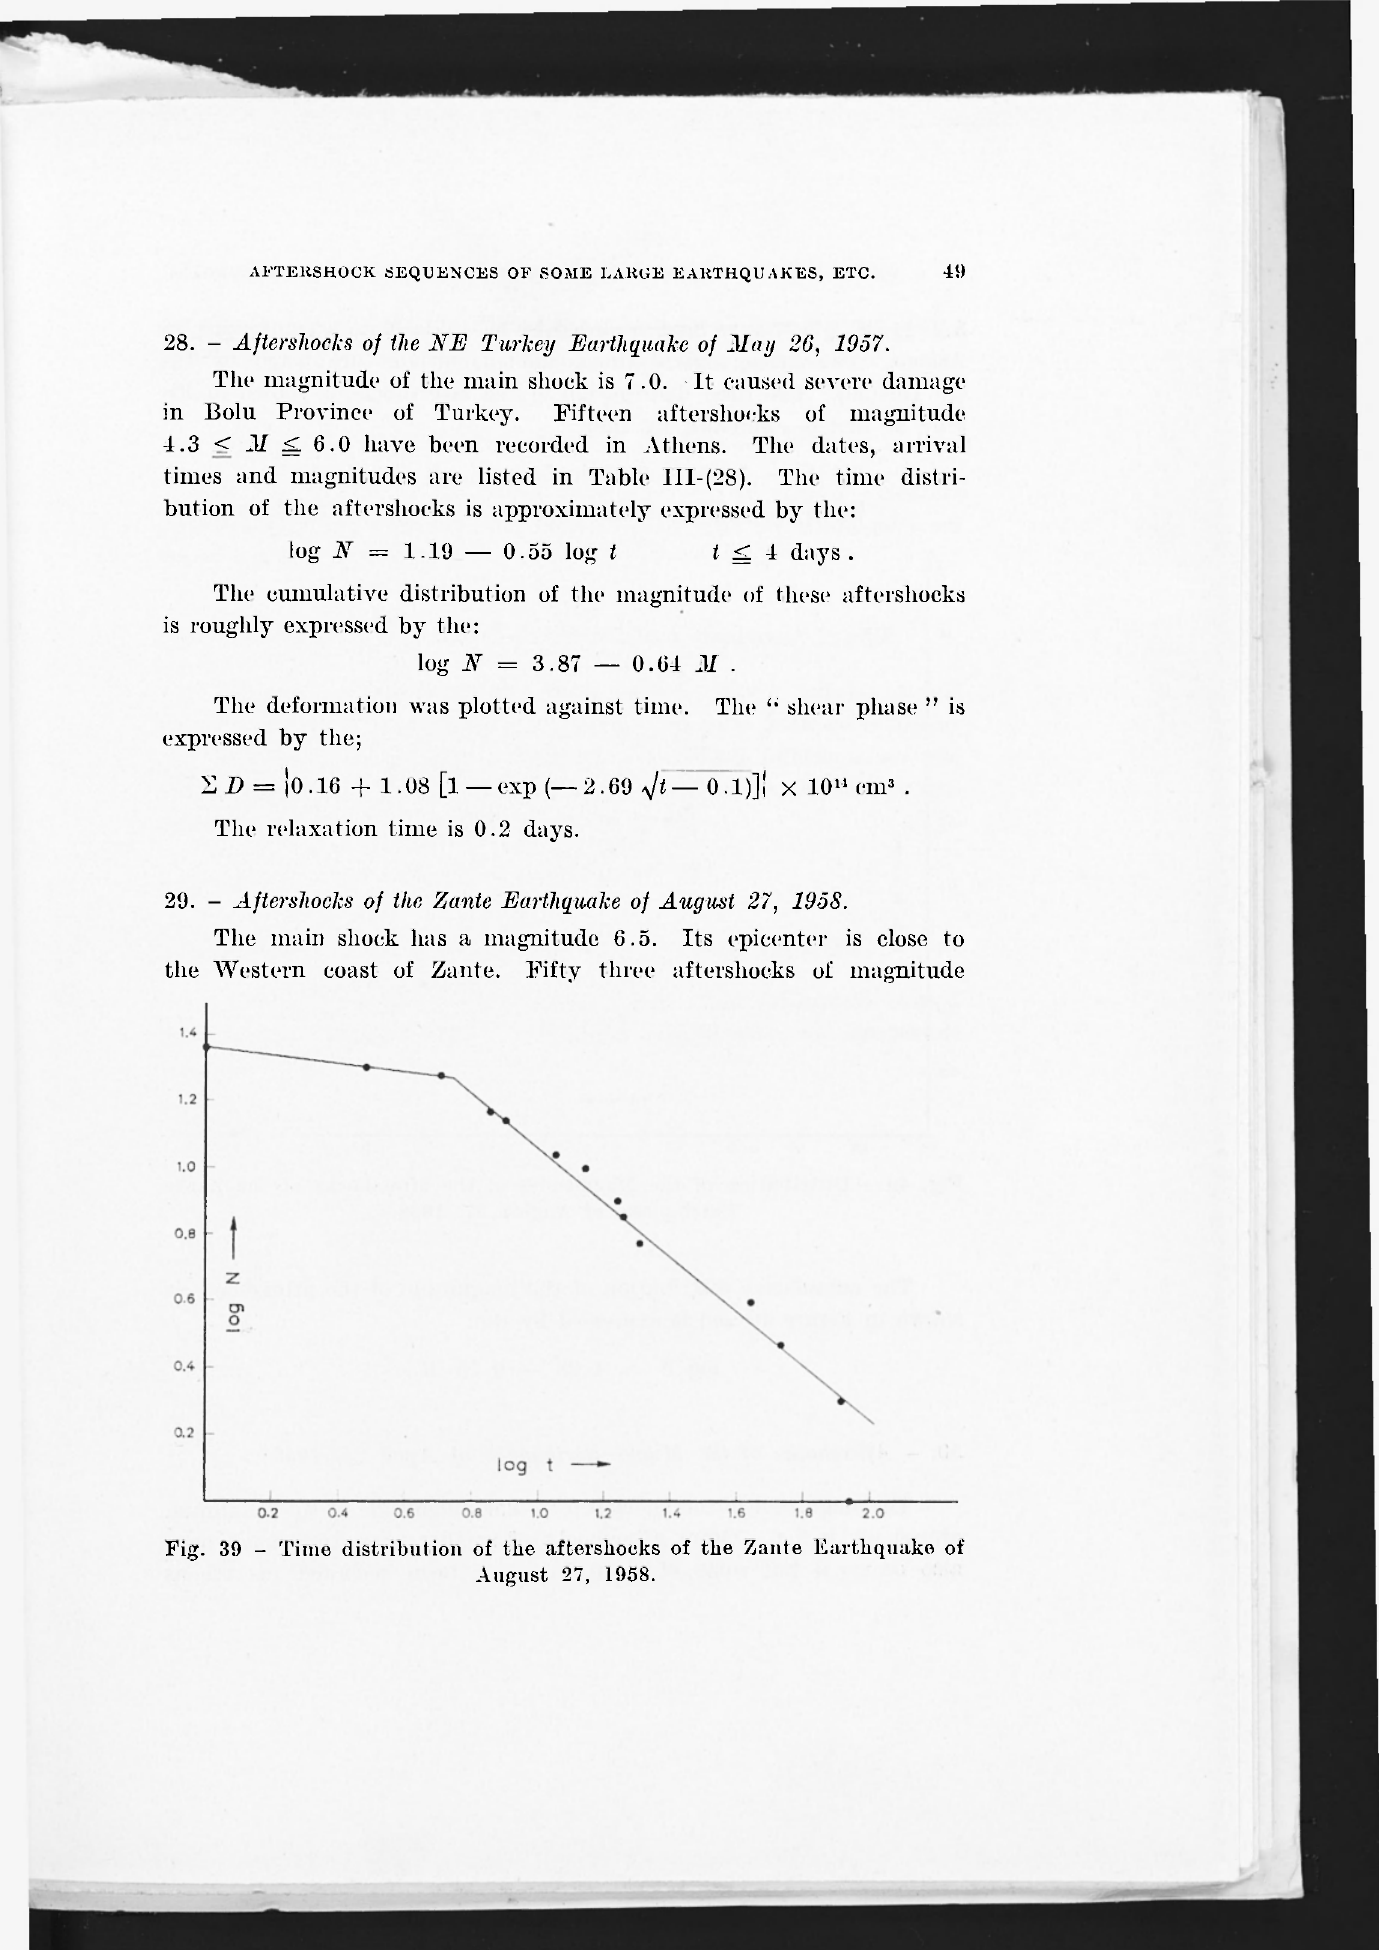
Fig. 39 - Time distribution of the aftershocks of the Zante Earthquake